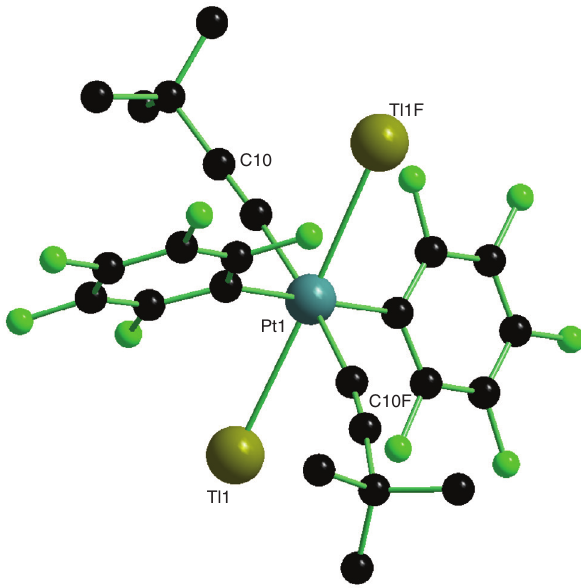
2.972(1) Å (Reis and Peterson, 1978). Another three yellow, monoclinic K